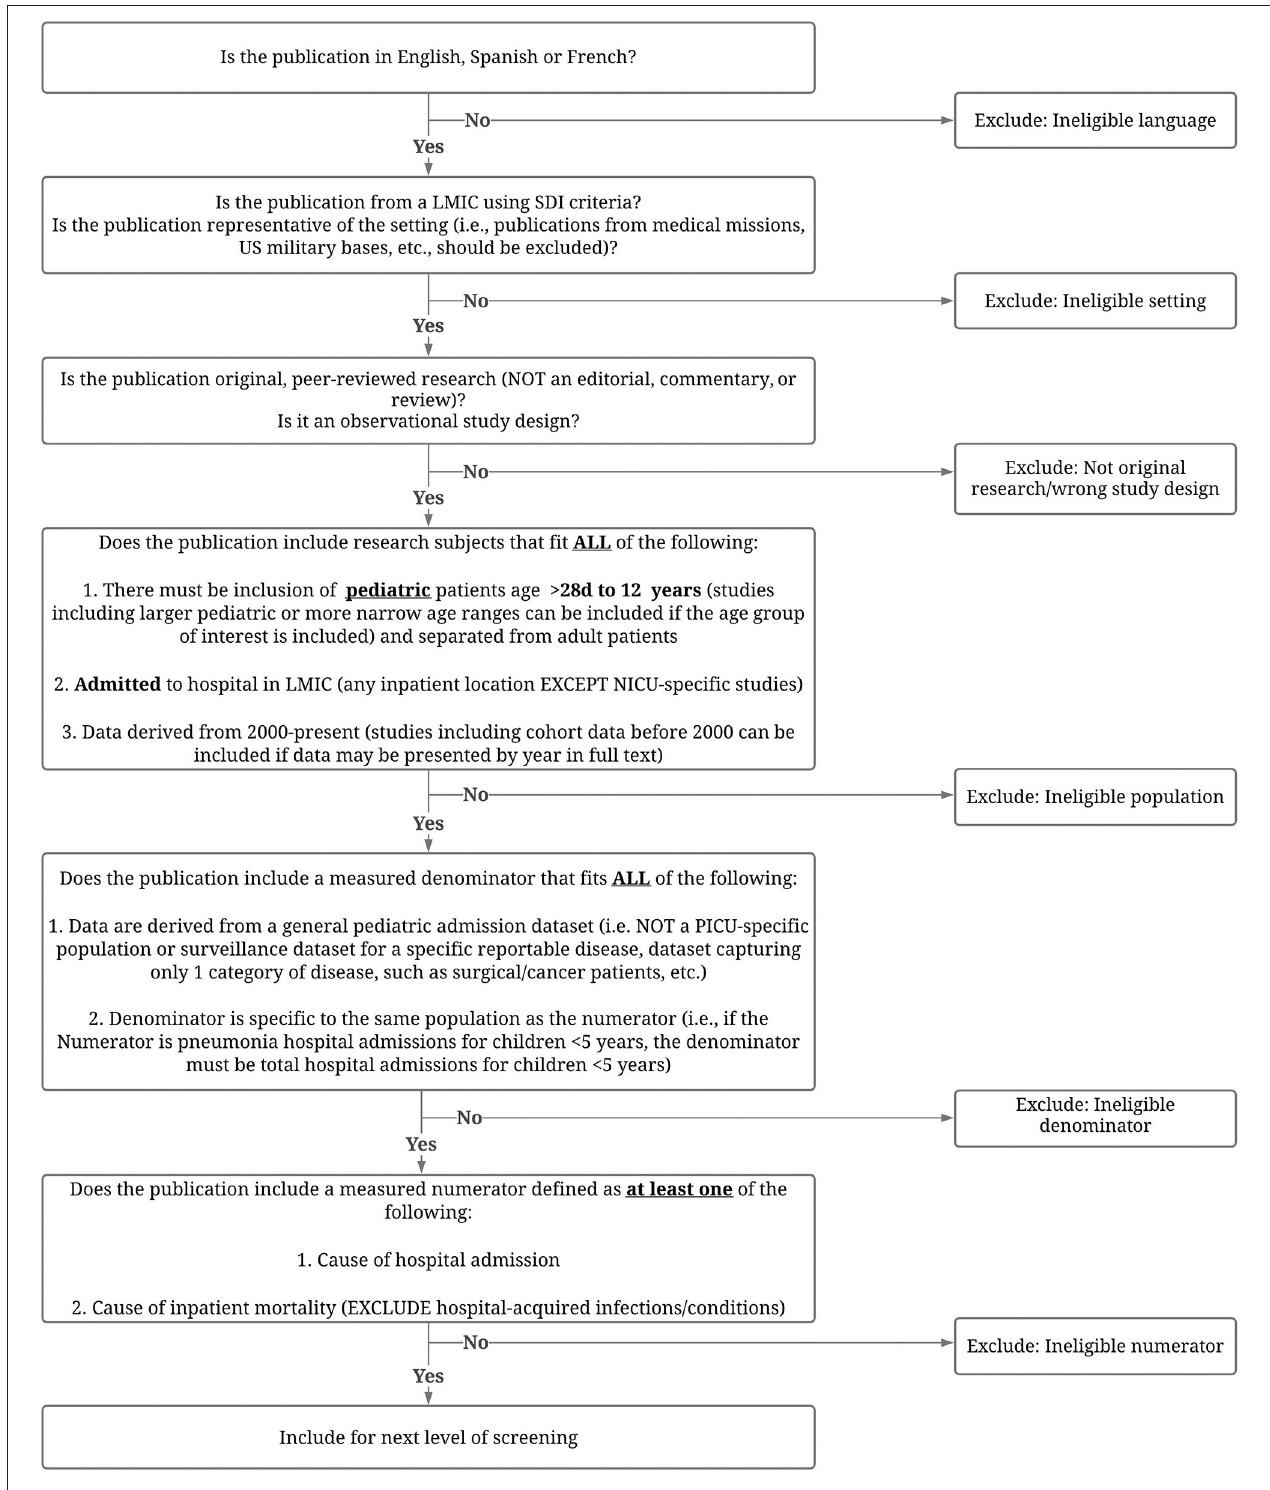
FIGURE 2 | Approach to screening abstracts, titles and texts for eligibility. LMIC, low- and middle-income country; SDI, Socio-Demographic Index; NICU, neonatal intensive care unit; PICU, pediatric intensive care unit.